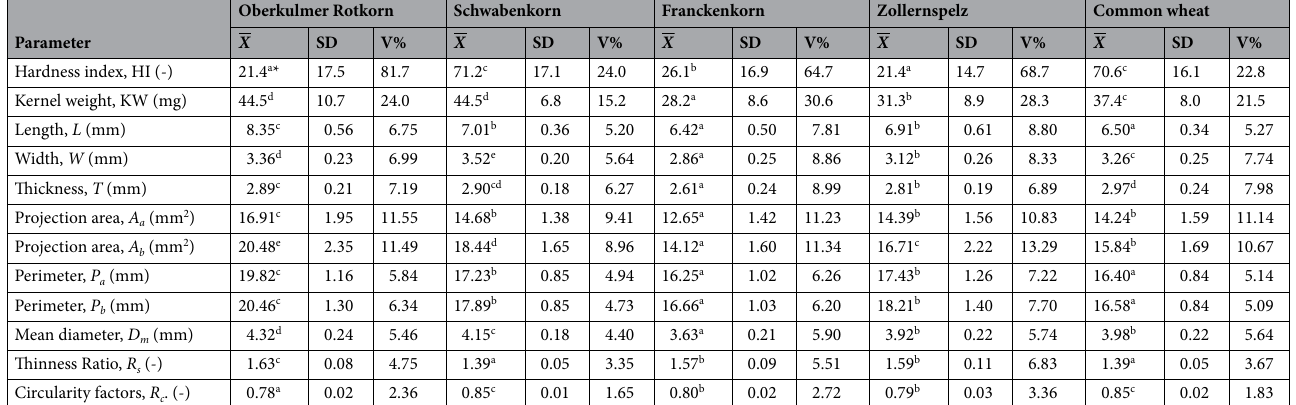
Table 1. Physical properties of spelt and common wheat grain. *Values marked with the same letters in rows are not significantly different at p ≤ 0.05; SD, standard deviation; V, coefficient of